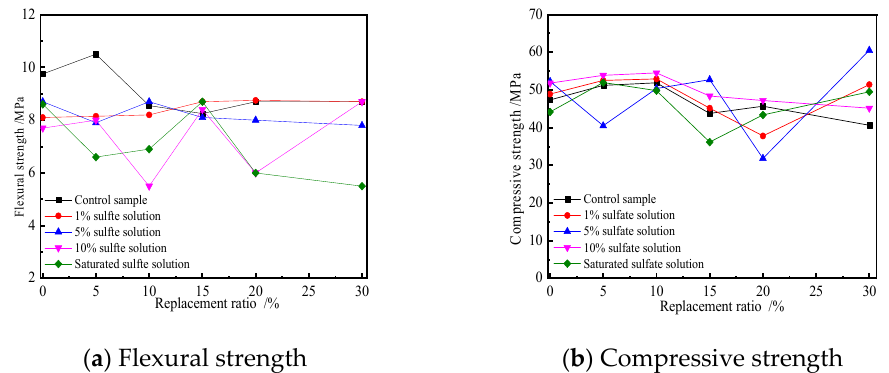
Figure 5. Variation curves of the strength of the mortars with replacement ratios of cement by slag.